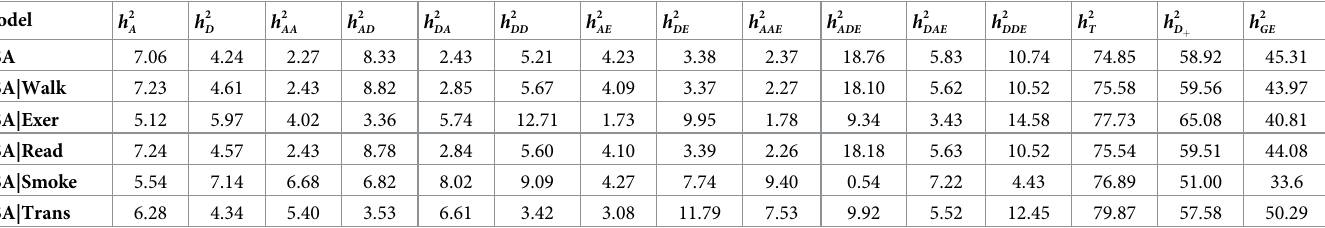
BSA = Base model for body surface area with additive, dominance and epistasis effects; BSA|Walk = Conditional model for body surface area with walk as a cofactor; BSA|Exer = Conditional model for body surface area with exercise as a cofactor; BSA|Read = Conditional model for body surface area with read as a cofactor; BSA| Smoke = Conditional model for body surface area with smoke as a cofactor; BSA|Trans = Conditional model for body surface area with transportation as a cofactor; Heritability: h 2 = heritability for additive effects, h 2 = heritability for dominance effects, h 2 = heritability for additive by additive (AA) epistasis effects; h 2 = A D AA AD heritability for additive by dominance (AD) epistasis effects; h 2 = dominance by additive (DA) epistasis effects; h 2 = heritability for dominance by dominance (DD) DA DD epistasis effects; h 2 = heritability for ethnicity-specific additive effects, h 2 = heritability for ethnicity-specific dominance effects; h 2 = heritability for ethnicity-specific AE DE AAE = heritability for ethnicity-specific additive by dominance (AD) and dominance by additive (DA) epistasis effects; h 2 = additive by additive (AA) epistasis effects; h 2 ADE DDE = total heritability; h 2 = sum of the heritability’s of dominance and dominance heritability for ethnicity-specific dominance by dominance (DD) epistasis effects; h 2 T D þ related epistasis